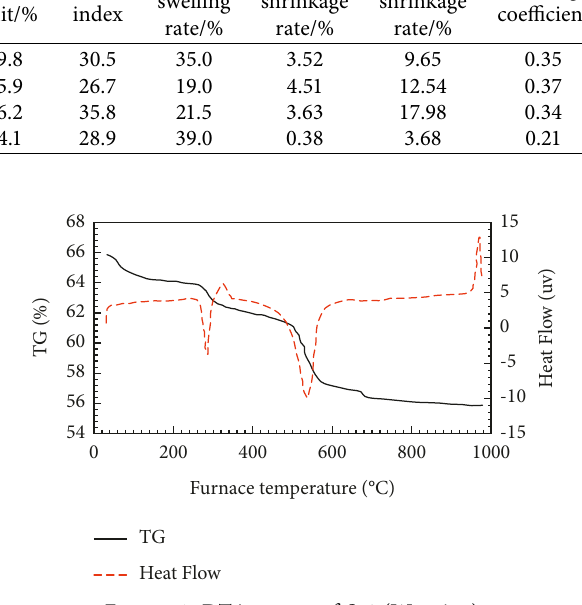
Figure 1: DTA curves of S-4 (Wuming).